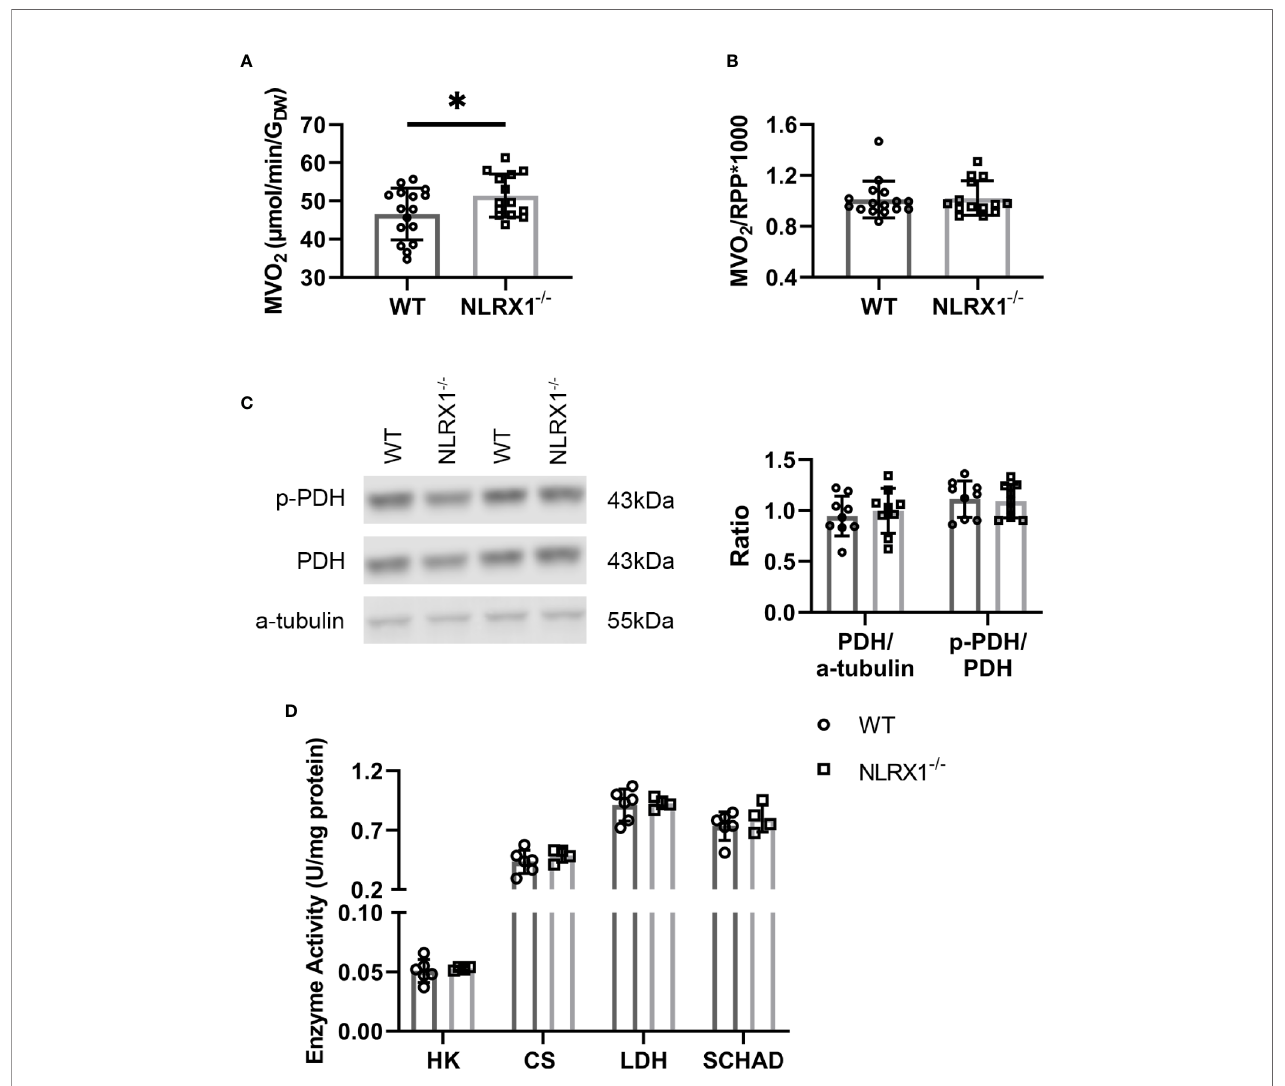
FIGURE 6 | Cardiac oxygen consumption and key metabolic enzymes in WT and NLRX1 -/- mouse hearts. (A) Myocardial oxygen consumption rate (MVO 2 ) and (B) MVO 2 /RPP at 25 min baseline perfusion (n=14-16 per group); (C) Total pyruvate dehydrogenase (PDH) relative to a -tubulin, and phospho-PDH (p-PDH) in hearts of both genotypes (n=9 per group); (D) Cardiac enzyme activities for hexokinase (HK), citrate synthase (CS), lactate dehydrogenase (LDH) and short chain 3- hydroxyacyl-CoA dehydrogenase (SCHAD) (n=4 – 6 per group). RPP, rate pressure product. Values represent mean ± SD. * P < 0.05 by t